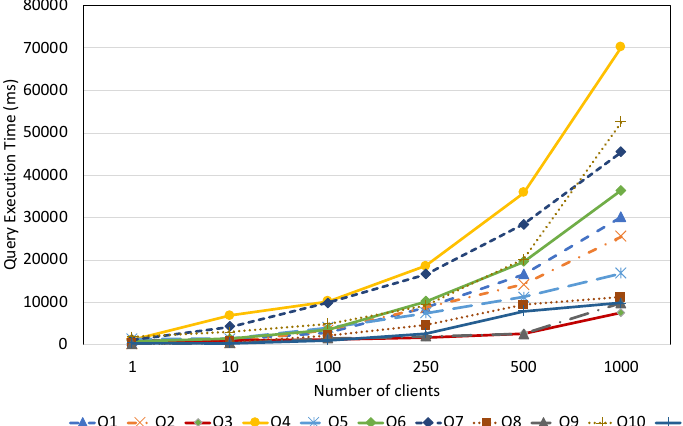
Figure 24. Average query execution time with respect to number of